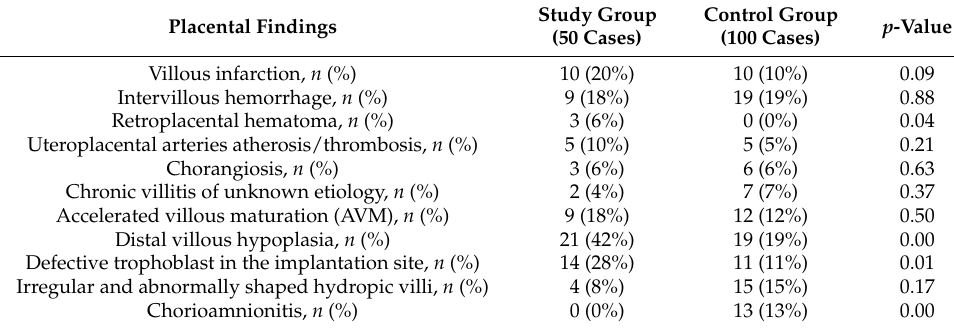
Table 2. Placental findings in study and control groups.